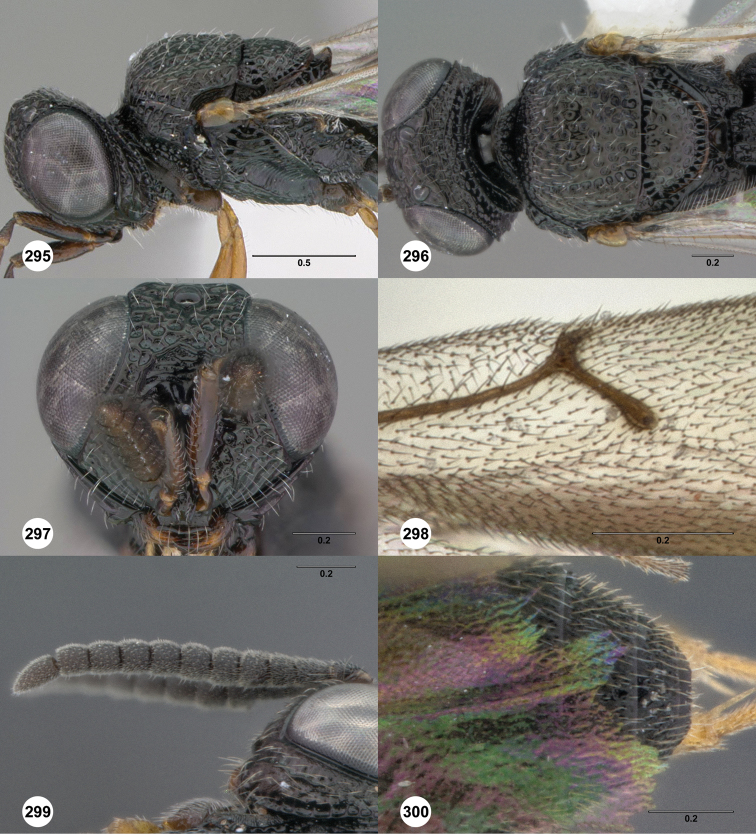
Oxyscelio sarcinae sp. n., holotype female (OSUC 439555) 295 Head and mesosoma, lateral view 296 Head and mesosoma, dorsal view 297 Head, anterior view 298 Fore wing venation. Paratype male (OSUC 439566) 299 Antenna 300 Metasoma, dorsal view. Morphbank84